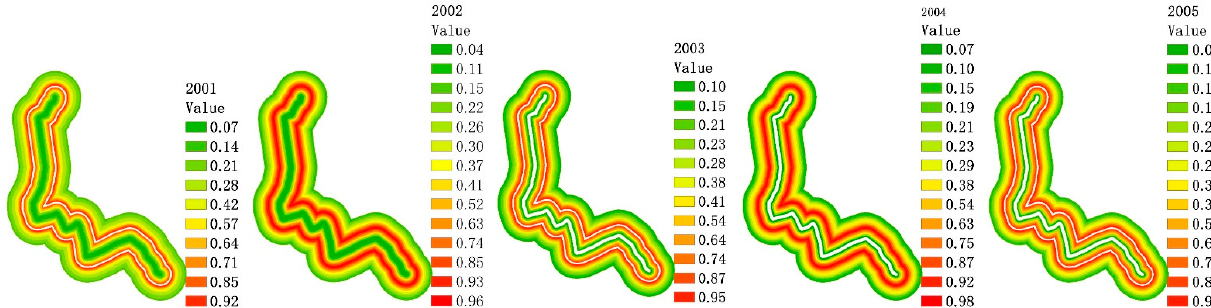
Figure 7. Transition potential maps generated by the LRT impact using the proposed method.